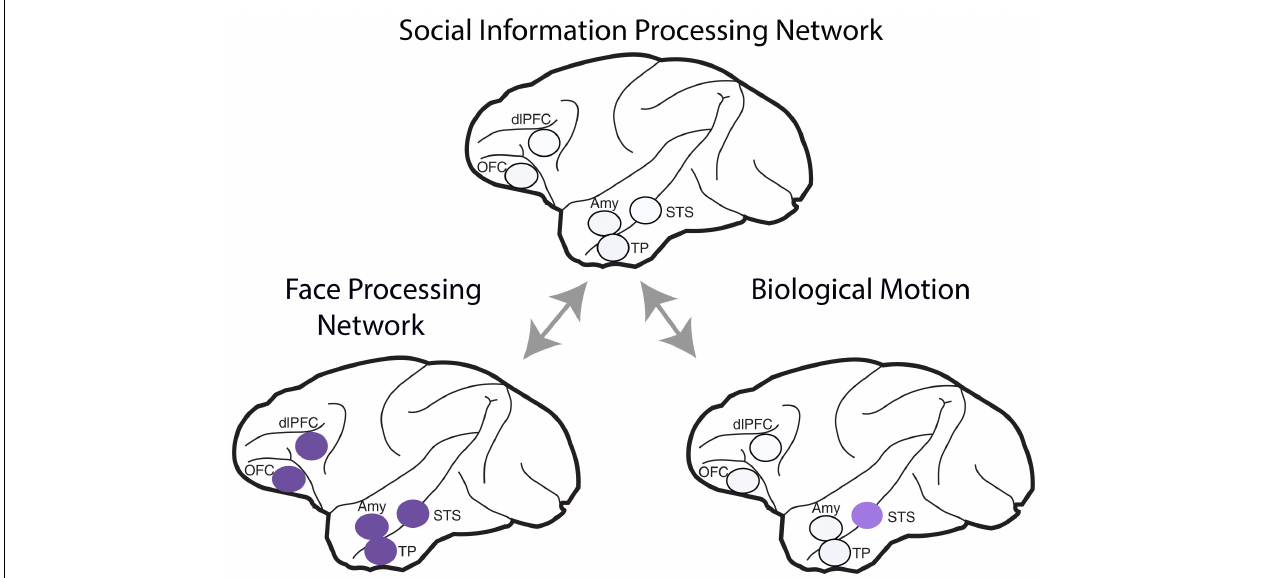
FIGURE 2 | Brain regions that comprise the social information processing network. The face-processing network includes the face patch areas along the superior temporal sulcus (STS), the temporal pole (TP), and the amygdala (Amy) within the temporal lobe, the lateral orbitofrontal cortex (OFC) and the dorsolateral prefrontal cortex (dlPFC) in the frontal lobe. Biological motion is encoded by neurons in the superior temporal sulcus (STS). Bidirectional arrows indicate the interdependence of these processes on acquiring social information. The areas are illustrated on a side view of a Rhesus brain.